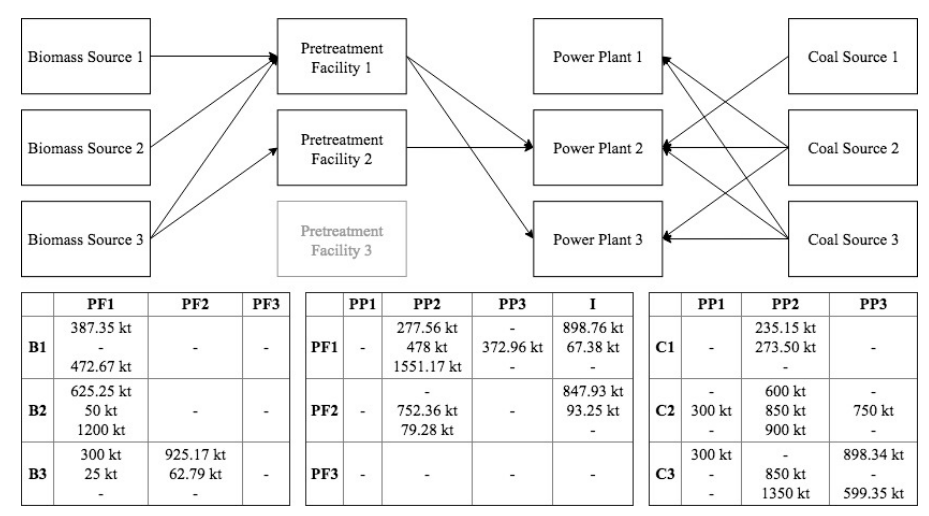
Figure 10. In the same way, when the properties in period 2 are made significantly better relative to period 3, the model chooses to purchase biomass for period 3 during the second period (Figure 11).